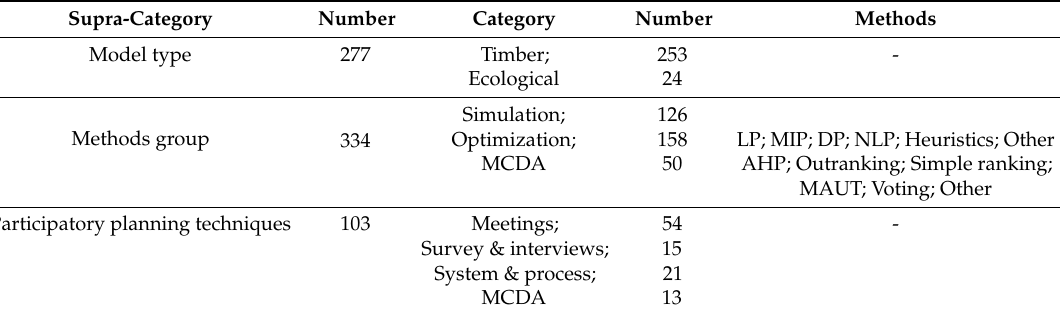
Figure 2. Methodology Description. Table 3. Categories of FMDSS by model and method, and the number of instances